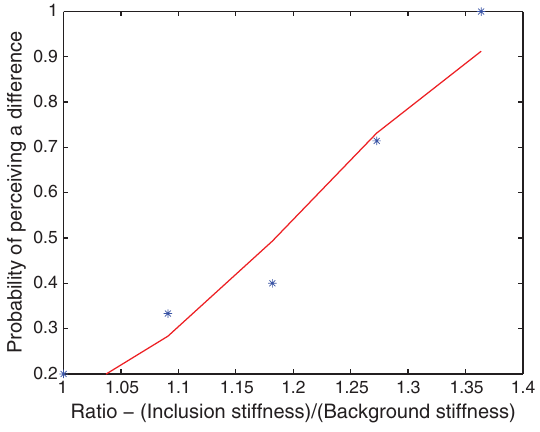
Table 3 Data Kalman filter. The amount of correct